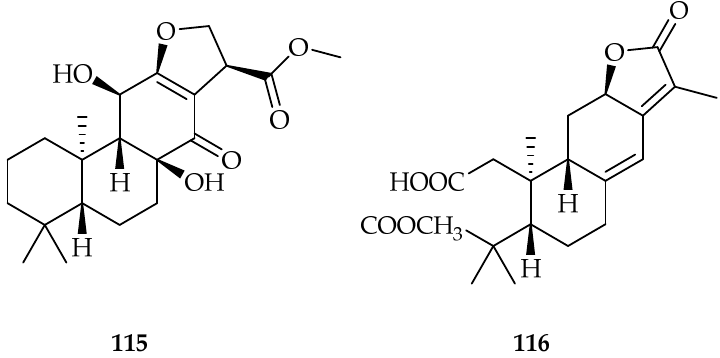
Figure 47. Structures of difischenoid A 115 and B 116 [71].